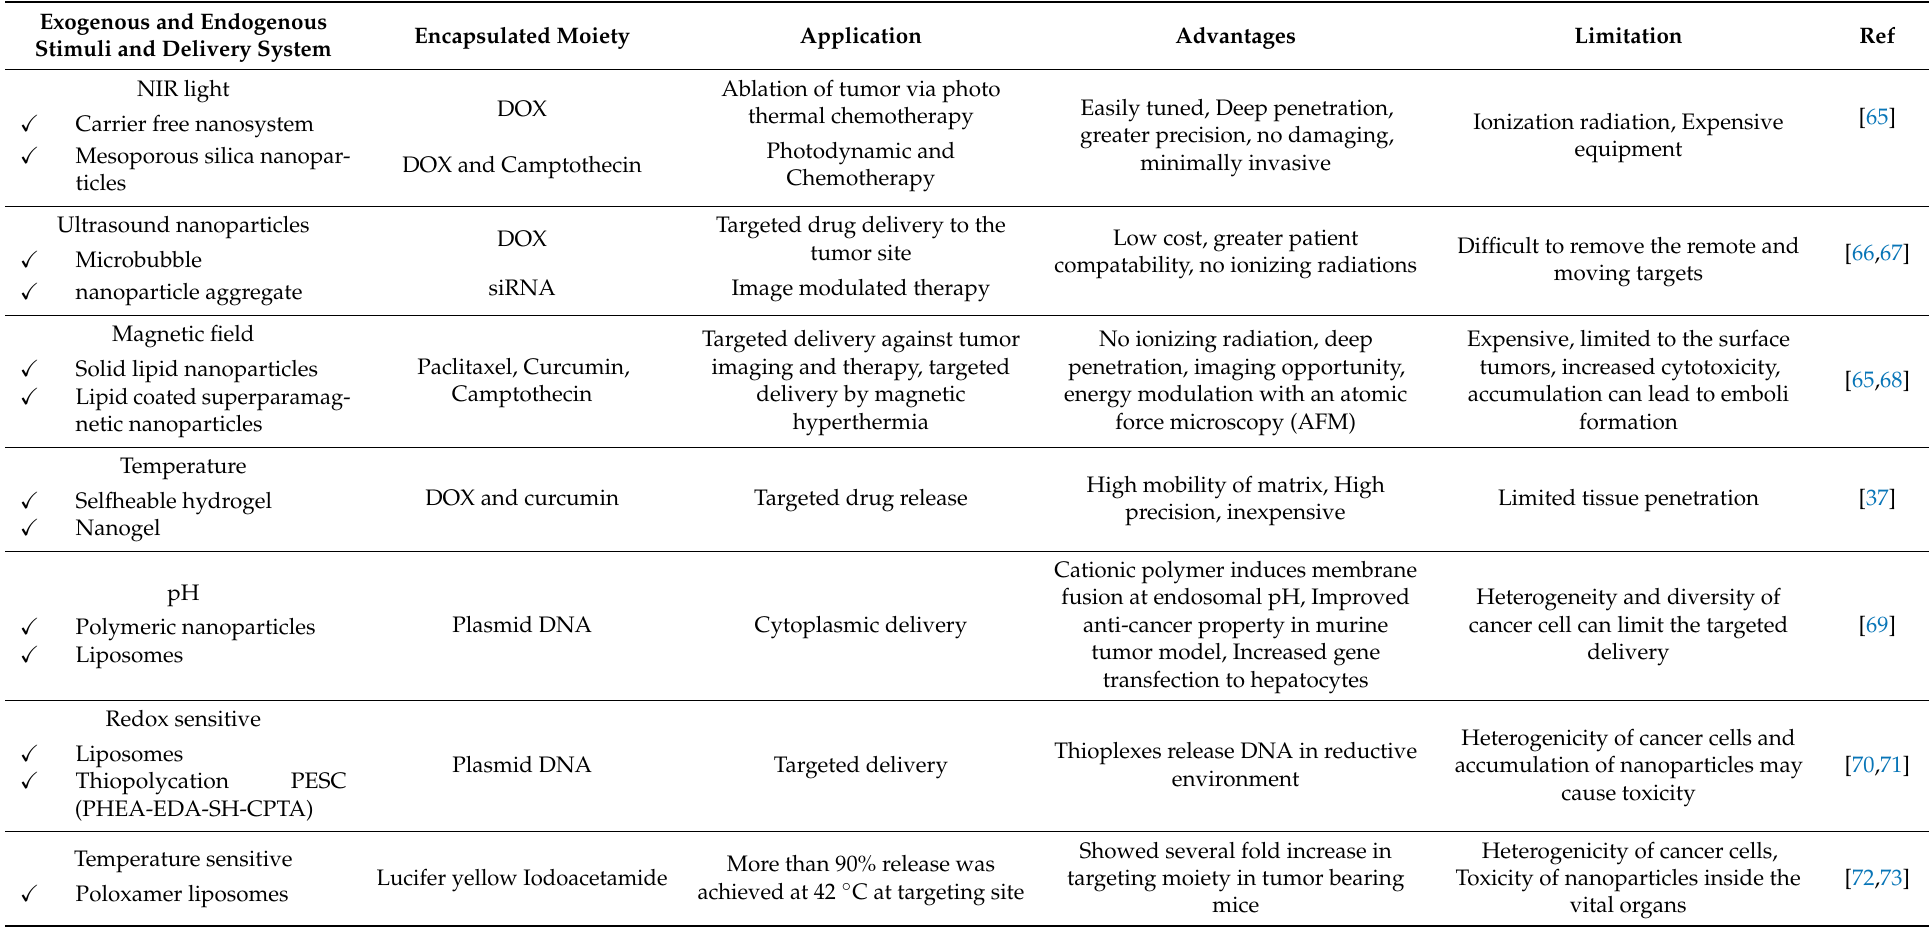
Table 2. Exogenous and endogenous stimuli and nanocarriers system for gene and drug delivery at tumor